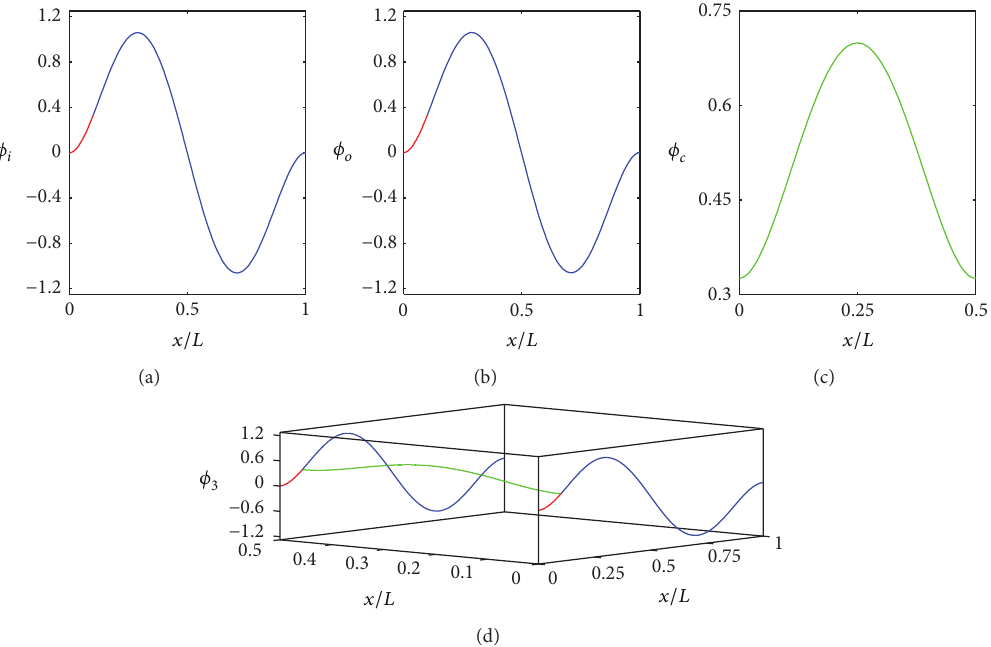
Figure 4: Third mode shape of the filter: (a) input, (b) output, (c) coupling beams, and (d) combination of (a), (b), and (c).